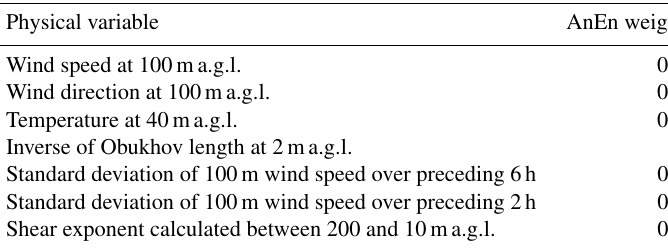
Table 4. Optimal weights associated with each physical variable in assessing the closeness of the match metric to identify the analogs.